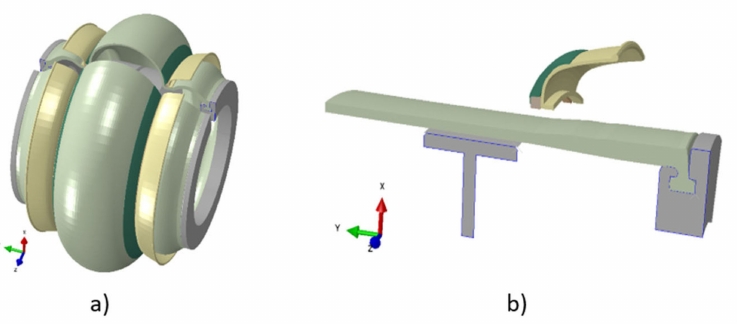
Figure 3. ( a ) Overall view of apexing using a DAM machine; ( b ) apex mounted on a bead, supported by a